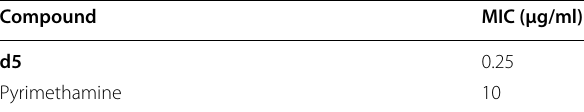
Table 34 Antimalarial in vitro activity against P. falciparum Compound